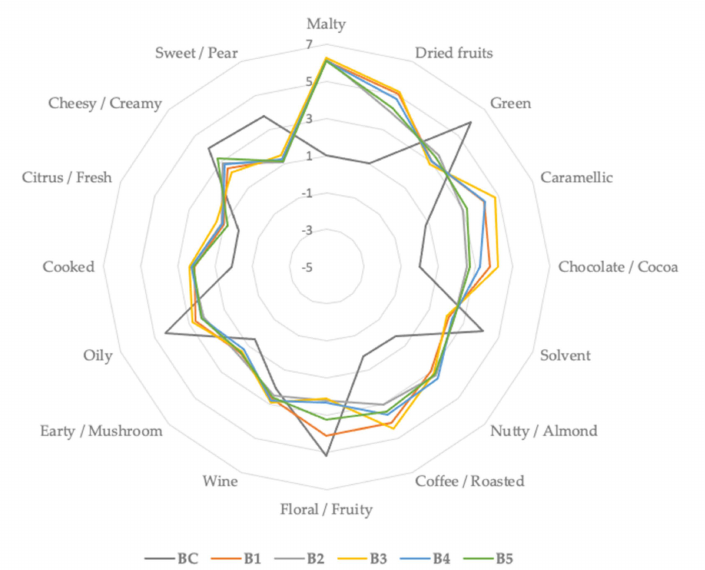
Figure 3. Aroma profile of control sample (BC) and samples with different BSG (brewers spent grains) types of main compounds classes identified during GC-MS